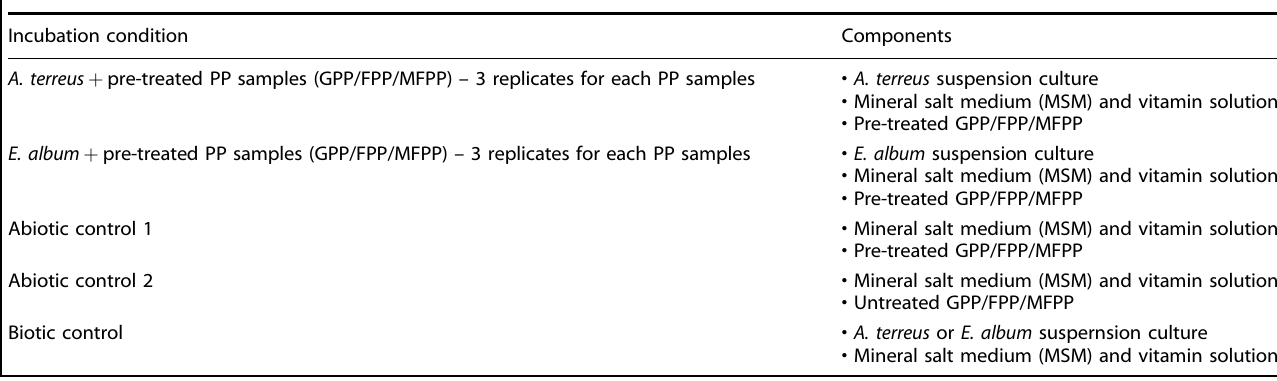
Table 1. Incubation condition of A. terreus and E. album